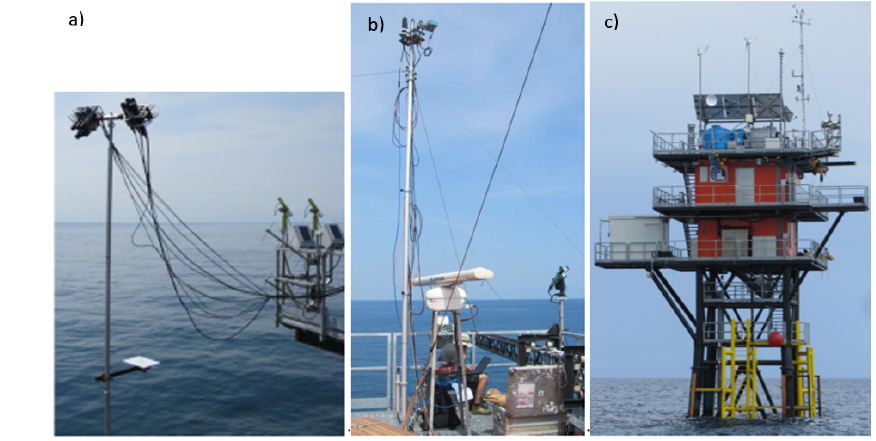
Figure 1. ( a ) Upwelling and downwelling radiance sensors mounted on a purpose-built mast; ( b ) Irradiance sensor mounted on a 6.6 m mast to minimise interference from overhead equipment on the tower; ( c ) The Acqua Alta Oceanographic Tower (AAOT). The radiance sensors were located on the middle platform on the right of the photo; the irradiance sensors were located on the top level. This tower is the site of the AAOT AERONET station which can be seen in this image on the highest